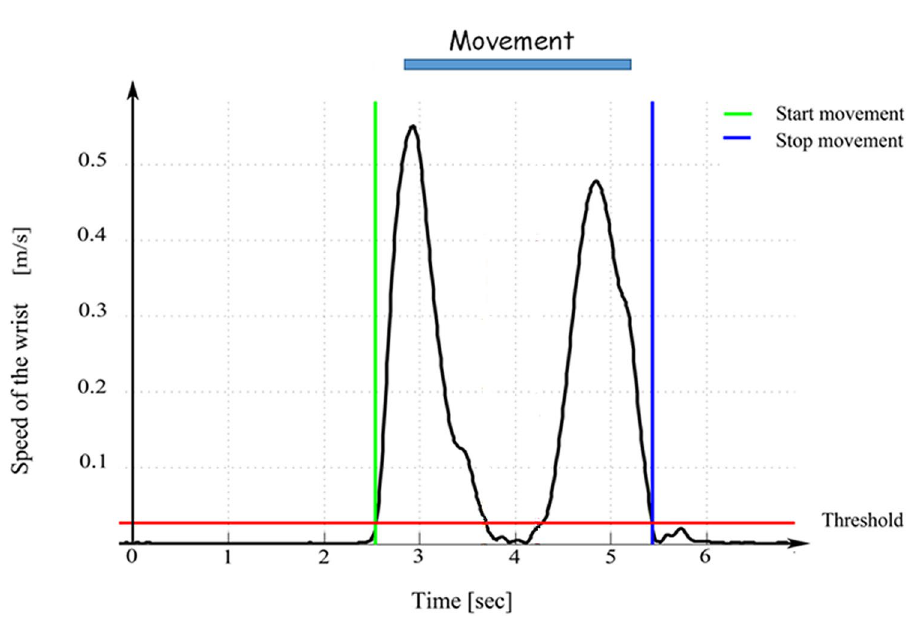
Figure 6. Speed of the wrist during the reach&grasp cycle. The red line indicates the 5% threshold used for marking the starting and ending timepoints of the